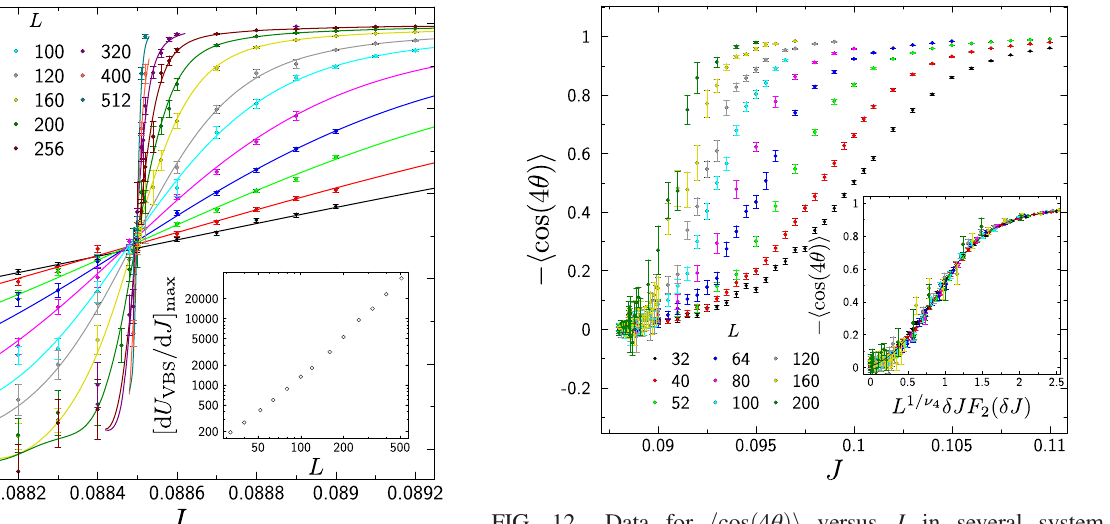
= d J versus L . VBS